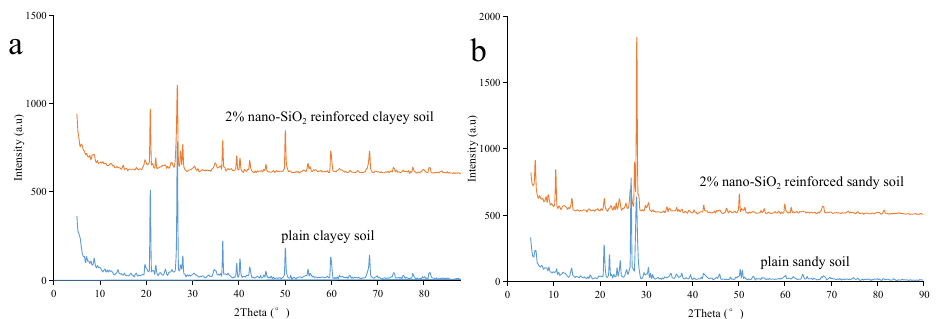
Figure 14. XRD diffraction patterns of the nano-SiO 2 -reinforced ( a ) clayey soil and ( b ) sandy soil.